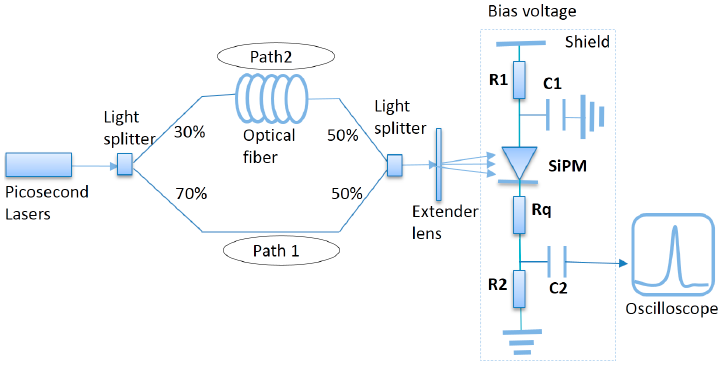
Figure 2. Schematic drawings of the experimental setup, optical fibers were used to change the time difference between two laser